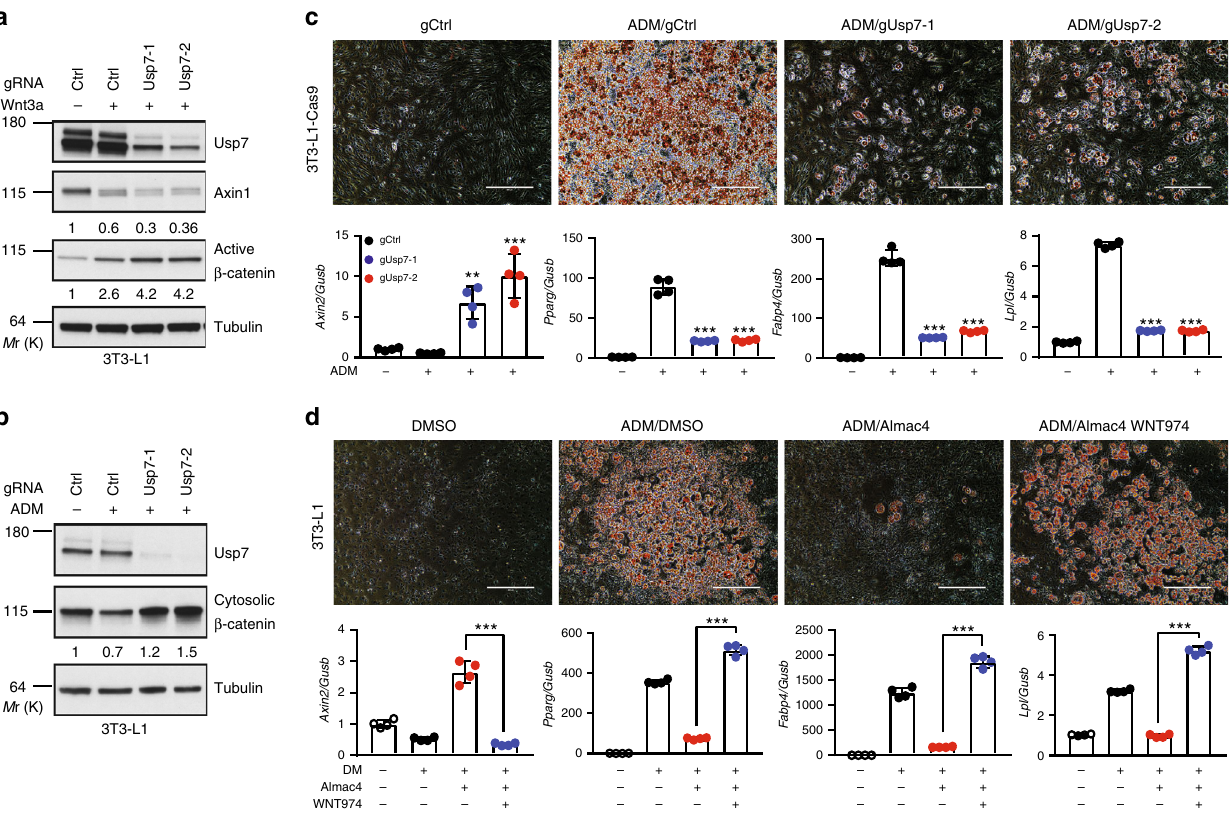
Fig. 6 USP7 promotes adipocyte differentiation through inhibiting Wnt signaling. a Knockout of Usp7 enhances Wnt3a-induced active β -catenin accumulation and Axin1 degradation in 3T3-L1 cells. Cells were incubated with 10% Wnt3a CM overnight and harvested for immunoblotting. b Knockout of Usp7 overcomes adipocyte differentiation medium (ADM)-suppressed expression of cytosolic β -catenin in 3T3-L1 cells. Cells were cultured in regular medium or differentiation medium for four days and harvested for immunoblotting. c Knockout of Usp7 attenuates adipocyte differentiation medium- induced lipid droplet formation (top panel), enhances the expression of β -catenin target gene, and suppresses the expression of adipogenic markers (bottom panel) in 3T3-L1 cells. 3T3-L1 cells were subjected to the standard differentiation protocol for ten days, and stained with Oil-Red O (top panels) or subjected to RT-PCR assay (bottom panels). Scale bars, 400 µ m. d Almac4 blocks adipocyte differentiation medium-induced lipid droplet formation and adipogenic marker expression, which is reversed by porcupine inhibitor WNT974. 3T3-L1 cells were subjected to the standard differentiation protocol in the presence of DMSO, 0.5 µ M Almac4, or 0.5 µ M Almac4 and 2 µ M WNT974 for ten days, and then cells were stained with Oil-Red O (top panels) or subjected to RT-PCR assay (bottom panels). Scale bars, 400 µ m. In Fig. 6c, d, error bars denote the SD between four replicates; one-way ANOVA was